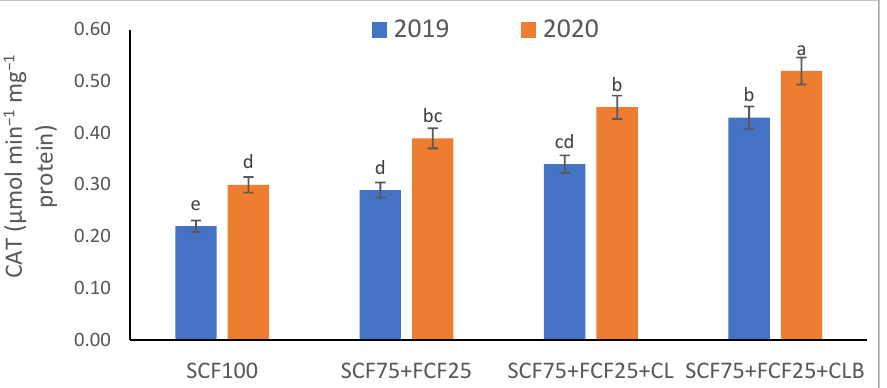
Figure 9. Response of leaf enzyme activity (superoxide dismutase—SOD) of Phaseolus vulgaris plants to different fertilization strategies applied in two seasons (2019 and 2020) to sandy soil. Abbreviations of fertilization treatments are explained in Table 1. Bars with a different letter indicate significant difference between treatments at p ≤ 0.05.